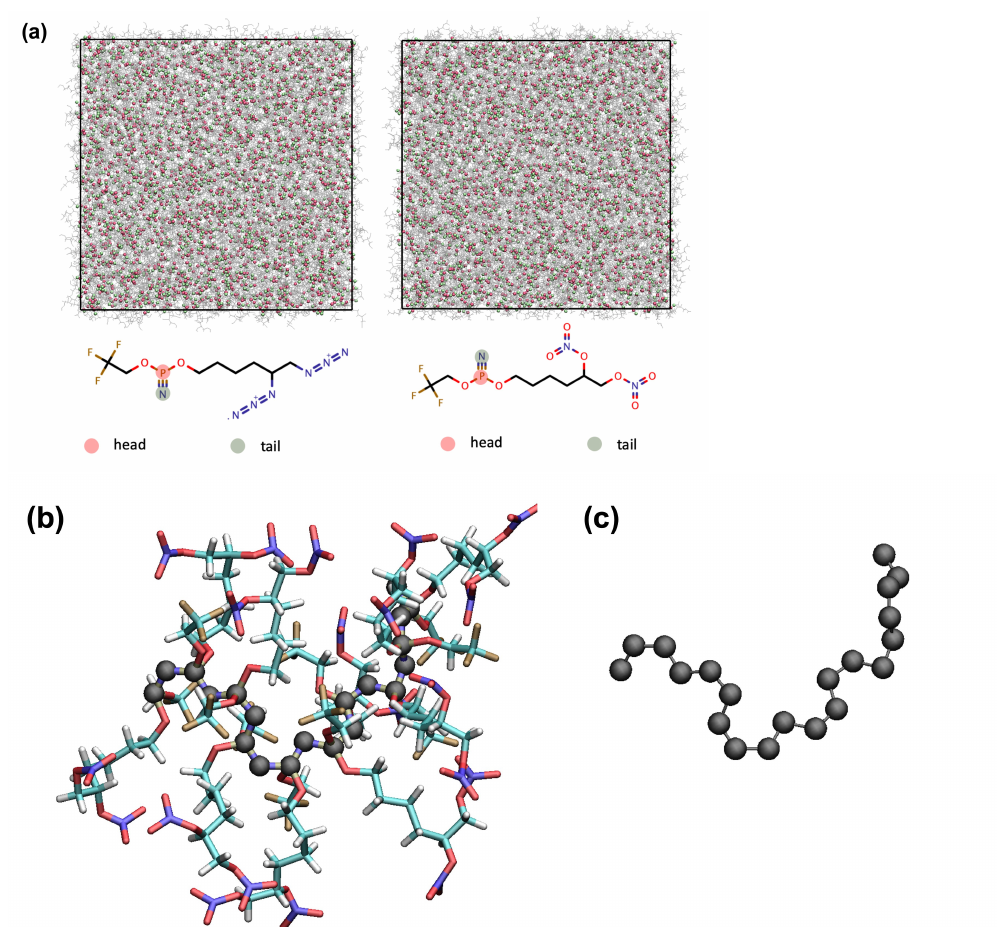
Figure 3. ( a ) A snapshot for the liquid PZ-Azido and PZ-Nitrato systems taken at the completion of the simulated annealing procedure at 50 ◦ C. ( b ) A polymer chain (up to 10 mers) of p-PZ-Nitrato. ( c ) The backbone of the polymer chain shown in ( b